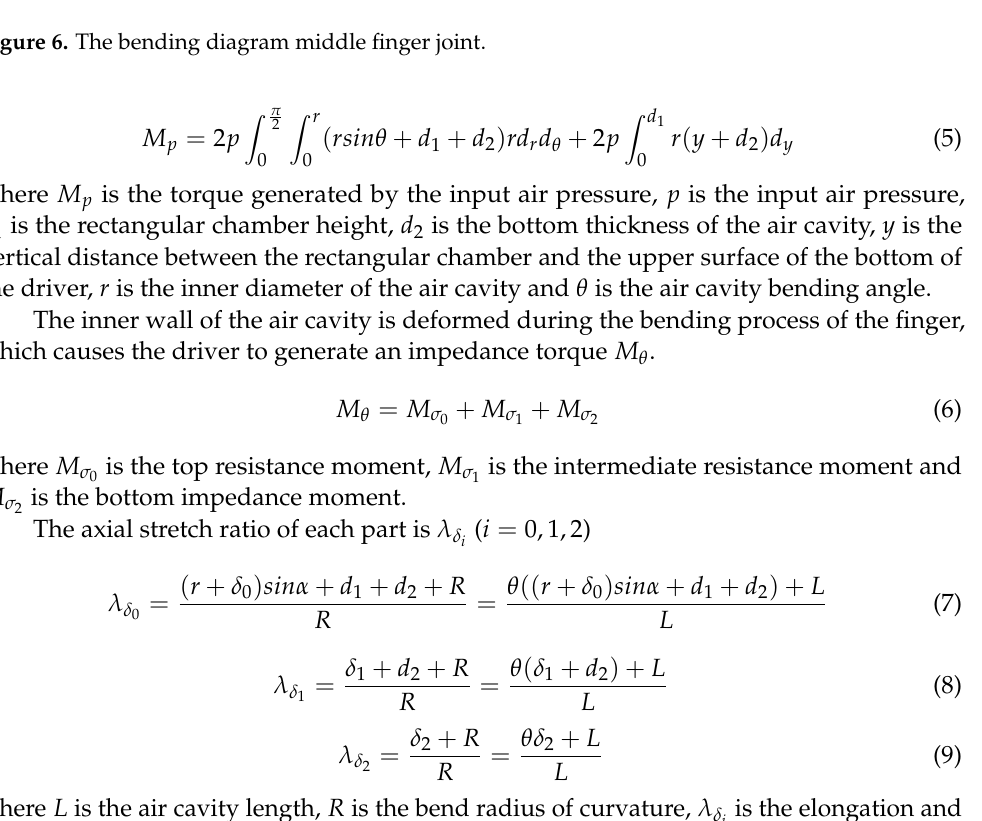
of the driver and the (cid:3043)